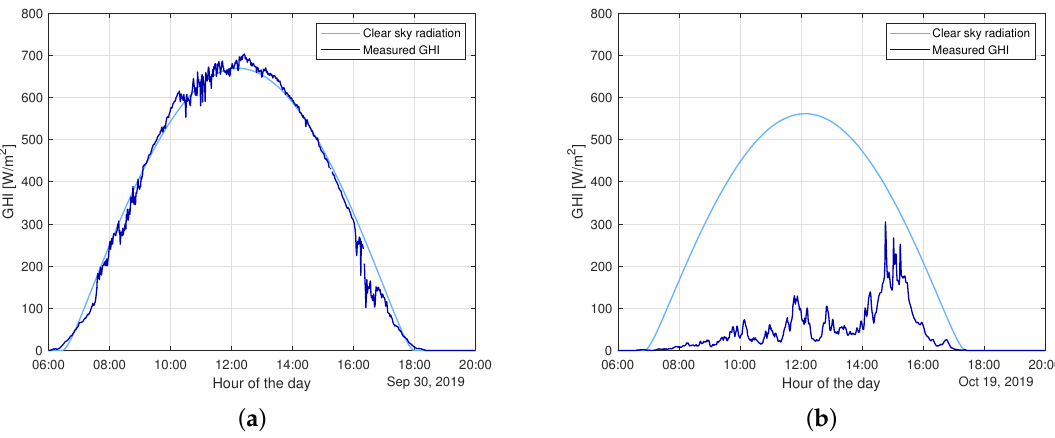
Figure 1. Measured GHI (Global Horizontal Irradiance) and computed clear-sky radiation for sunny ( a ) and cloudy ( b ) days measured at SolarTech Lab of Politecnico di Milano.